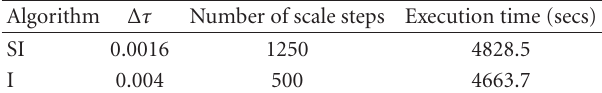
Table 10: Test 2: Comparisons between two algorithms: E d = O (10 − 3